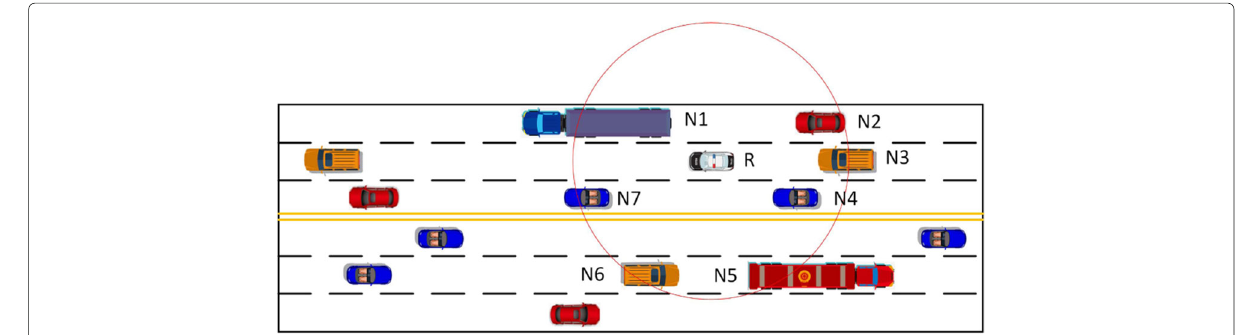
Fig. 3 Utilizing broadcast as a forwarding strategy in dense